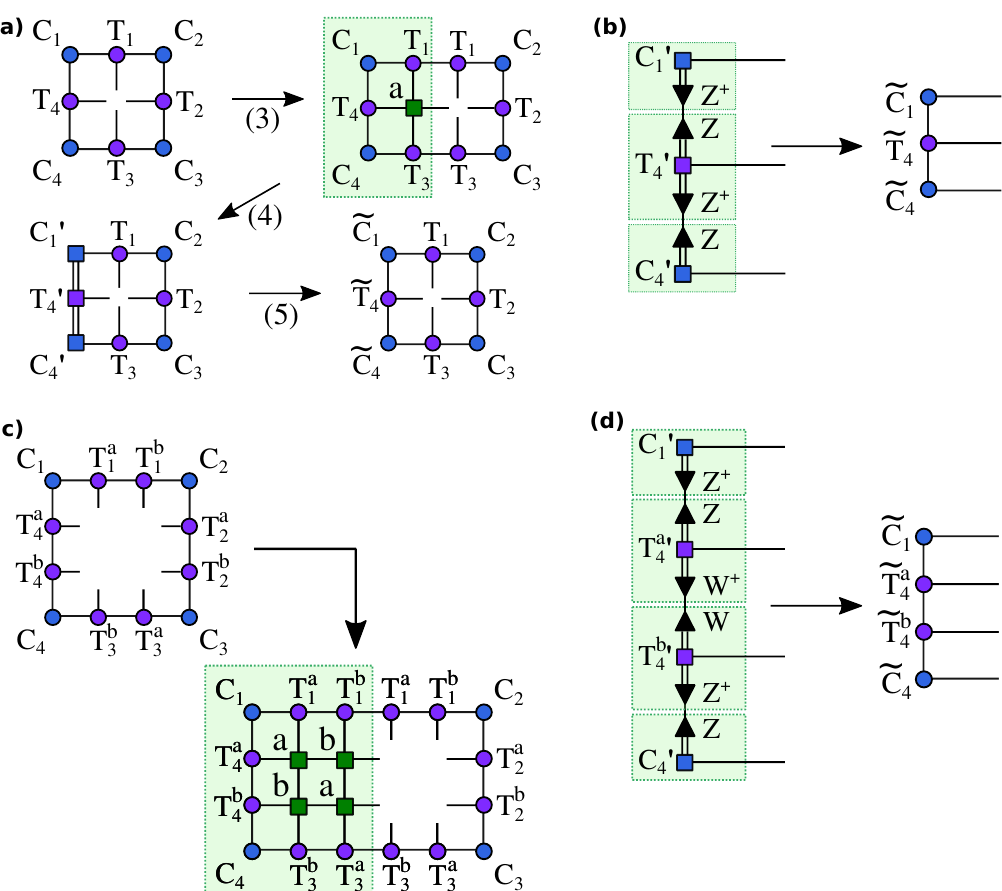
Figure 8: (a) The main steps (3-5) of the left move of the CTM algorithm for a one-site unit cell containing tensor a . (b) The renormalization step (5) is done by inserting isometries ZZ + = I into the left edge of CTM network. (c) The insertion step of the left move of the CTM algorithm for a two-site unit cell containing tensors a , b . (d) The renormalization step for a two-site unit cell is done by inserting two types of isometries, ZZ + = I and WW + = I